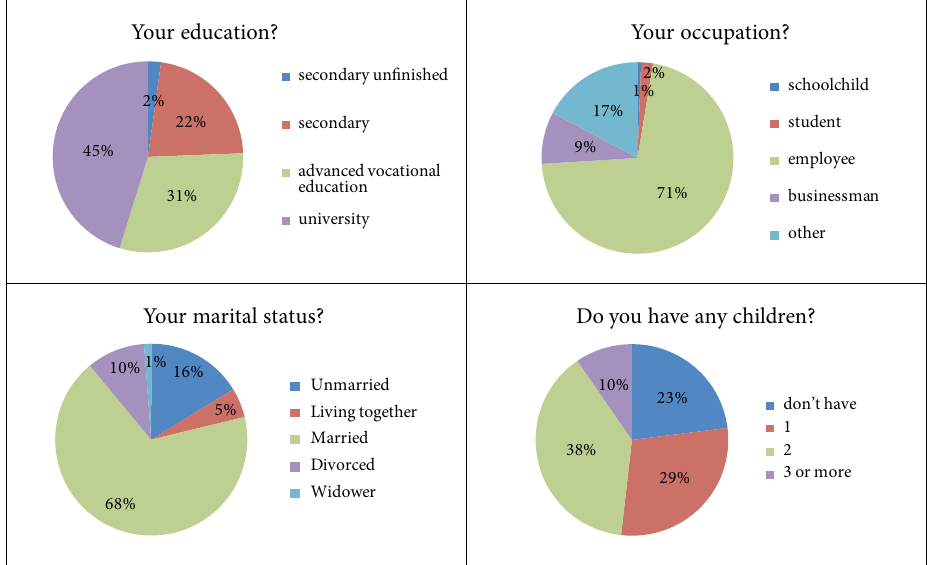
Fig. 5. Demographic and socio-economic indicators of respondents (authorial computation, according to the survey